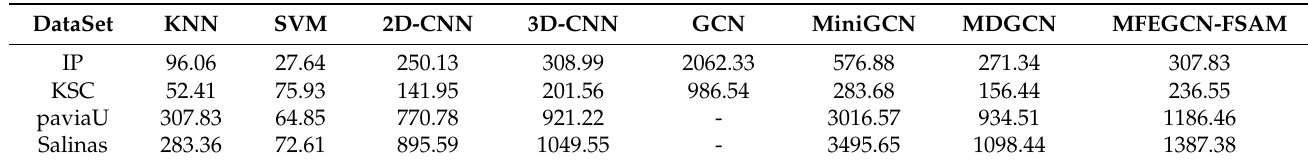
Table 10. Running time comparison of different